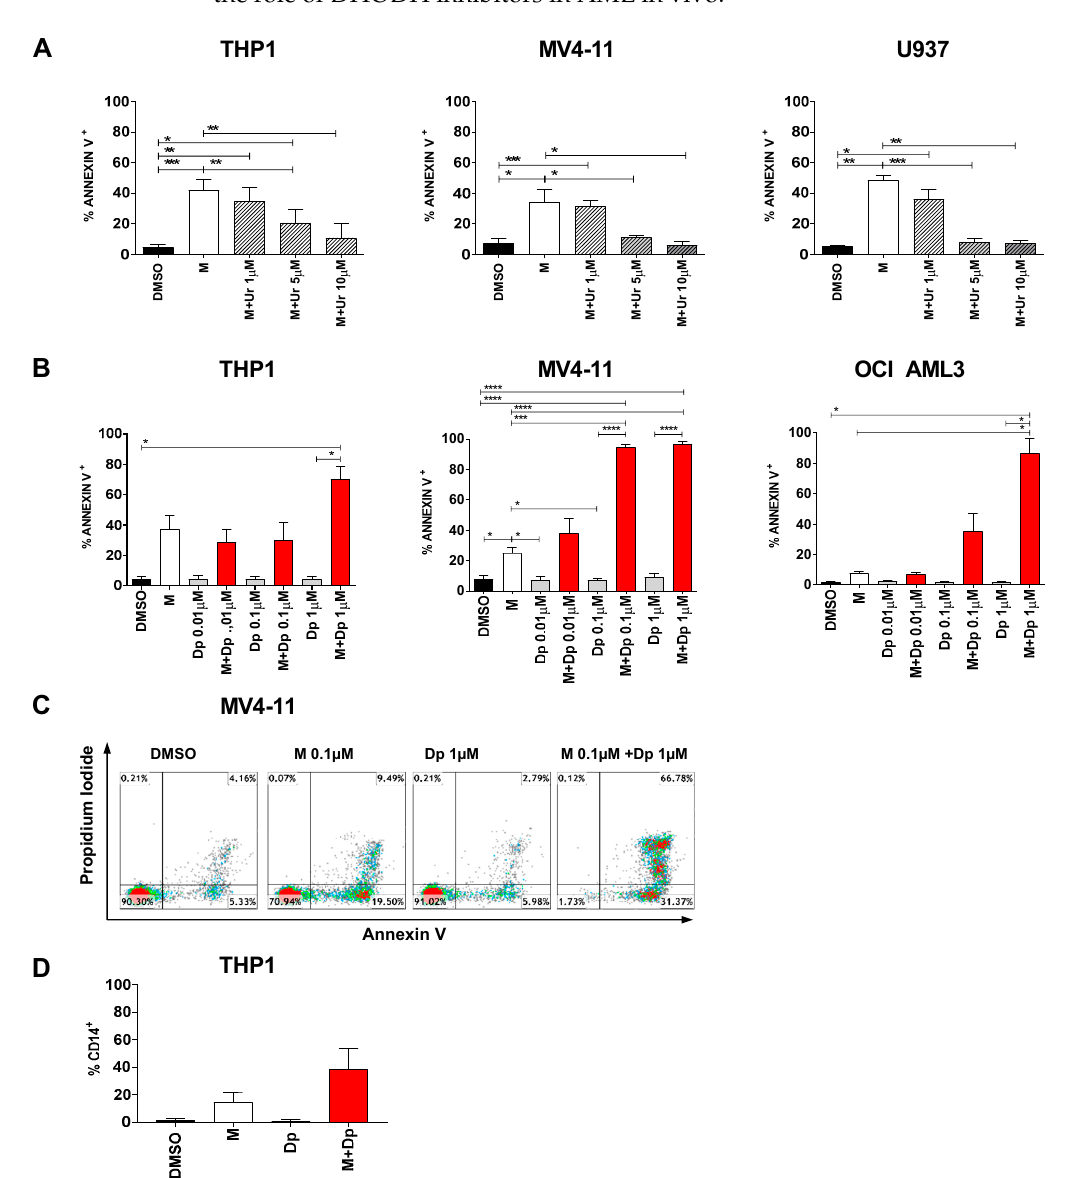
Figure 6. The combination of MEDS433 and dipyridamole results in synergistic effects. ( A ) Analysis of the apoptotic rate induced by MEDS433 on THP1 ( n = 4), MV4-11 ( n = 3) and OCI-AML3 cells ( n = 3), when utilized alone or in the presence of uridine at low concentrations (1 to 10 µM). ( B ) Apoptosis induced by MEDS433, dipyridamole and their combination on THP1 ( n = 3), MV4-11 ( n = 3) and OCI-AML3 cells ( n = 3). ( C ) Flow cytometry plots on a representative experiment on MV4-11 cells treated with MEDS433, dipyridamole and their combination ( D ) Differentiation induced by MEDS433 and dipyridamole, alone or in combination, on THP1 cells; the differentiation analysis was performed on day 2 ( n = 3). In all experiments, MEDS433 was utilized at 0.1 µM and apoptosis was evaluated after 3 days of treatment. DMSO: dimethyl sulfoxide. M: MEDS433. Dp: dipyridamole. Statistical significance: Anova/Tukey, * p < 0.05; ** p < 0.01; *** p < 0.001; **** p < 0.0001.